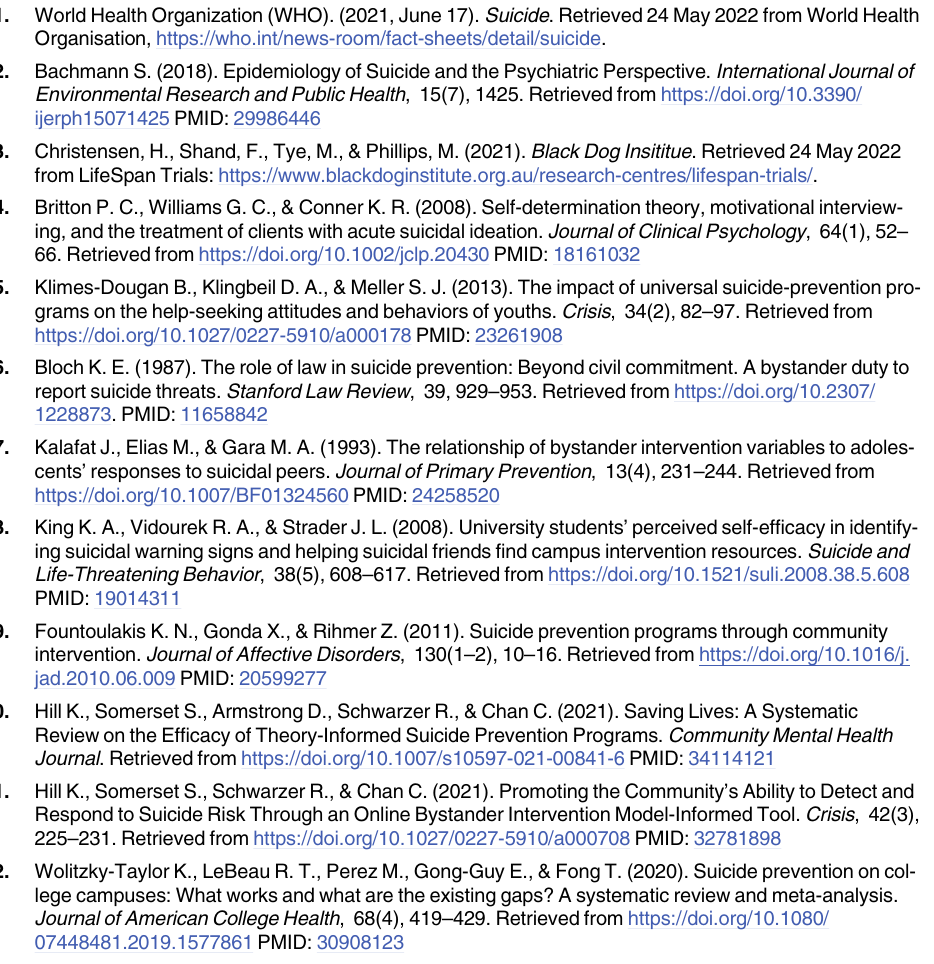
S1 Table. PRISMA-P 2015